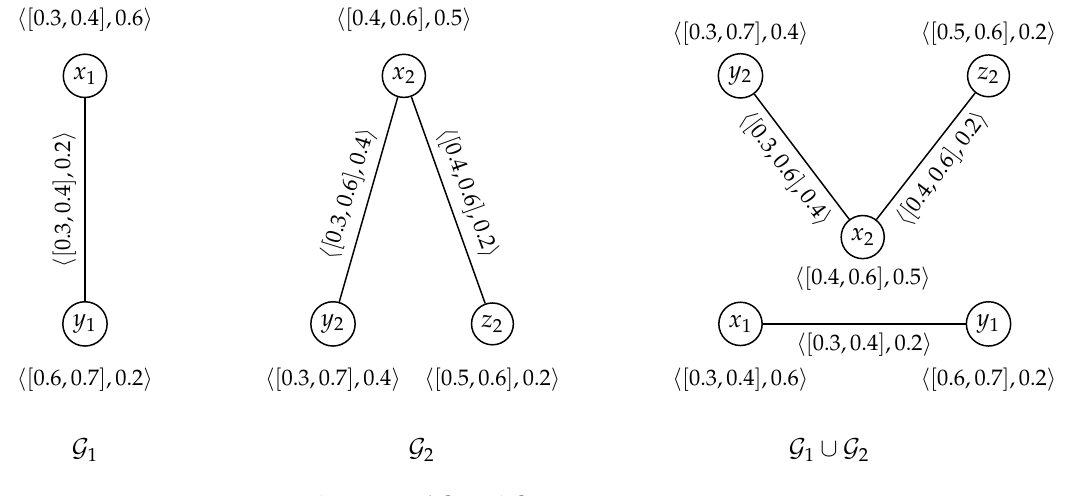
Figure 3. The union of G 1 and G 2